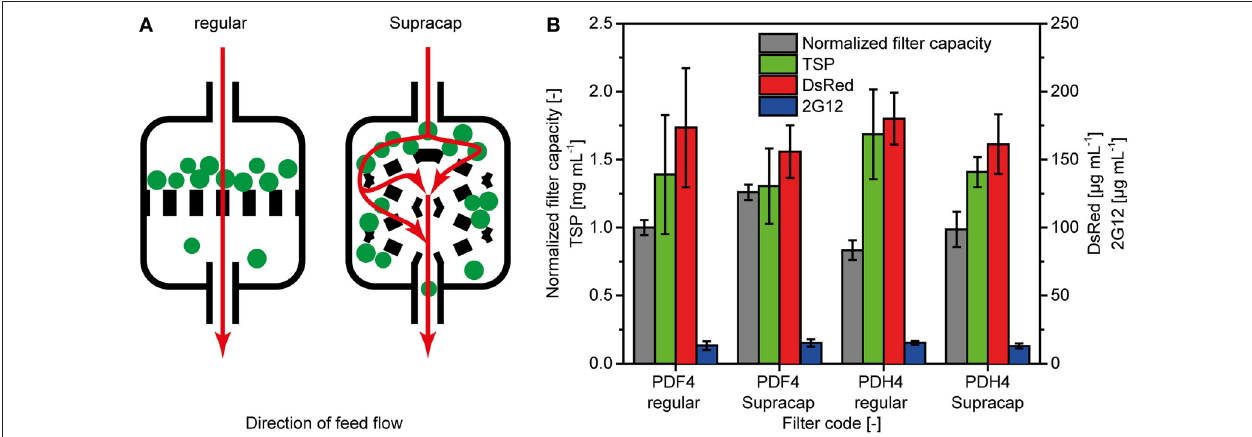
FIGURE 3 | Differences between depth filters with simple and authentic layer geometries. (A) Schematic representation of the liquid flow pattern (red arrows) and particle deposition (green dots) on depth filters with simple geometry (regular) typically used during initial testing, and scaled-down devices with authentic layer conformation (Supracap). (B) Comparison of filter capacity and protein binding properties between regular and Supracap filter geometries. TSP, DsRed and 2G12 concentrations in filtrates were determined by the Bradford method, fluorescence spectroscopy and SPR spectroscopy, respectively. Error bars indicate standard deviations ( n ≥ 3